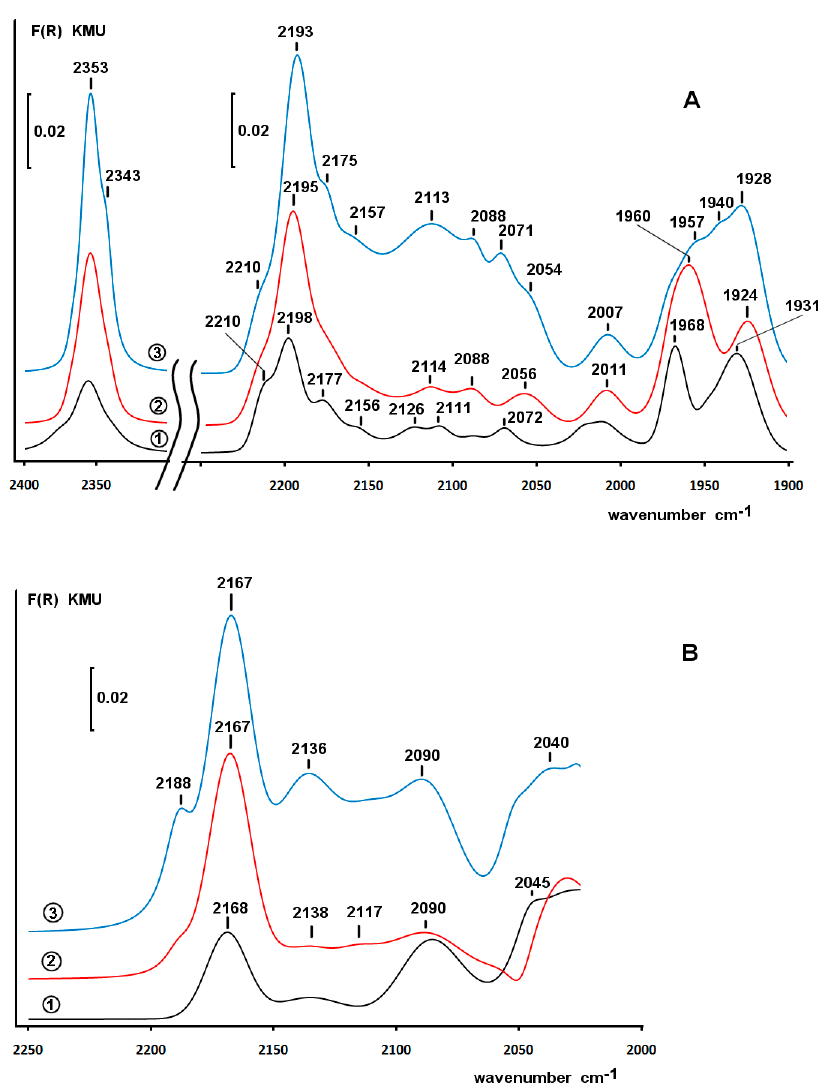
Figure 6. Difference DRIFT spectra of CO adsorbed at room temperature on Fe/ZS(550) before ( A ) and after H 2 treatment ( B ). CO pressure: 5 Torr—curve 1; 20 Torr—curve 2; 50 Torr—curve 3. F(R)—Kubelka–Munk function (Kubelka–Munk units).